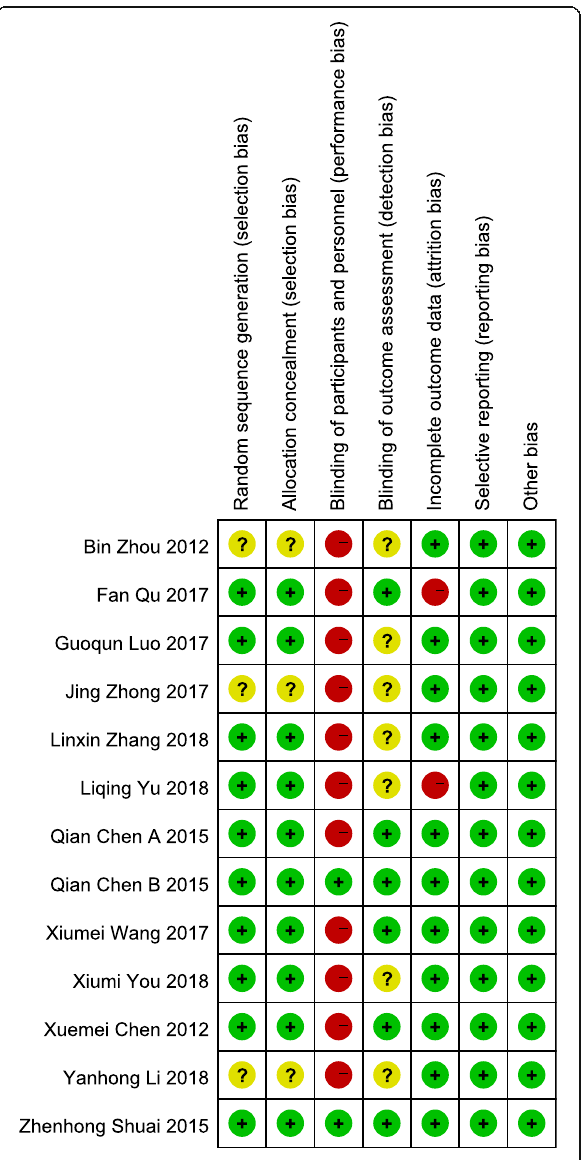
Fig. 3 Risk of bias